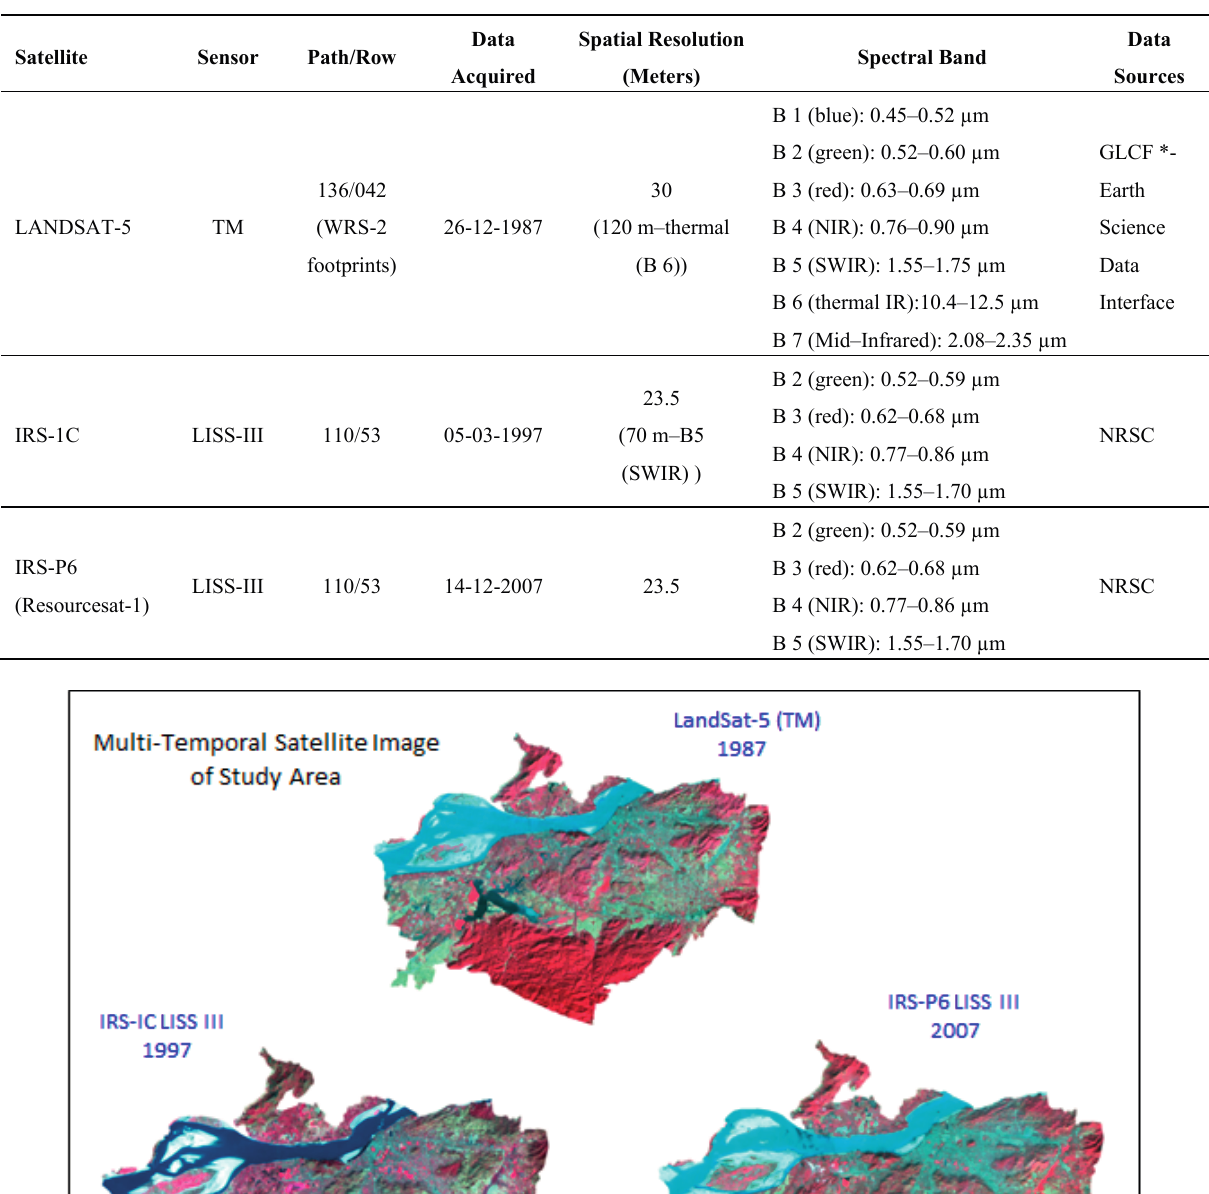
Table 1. Details of satellite data used in the study [9].